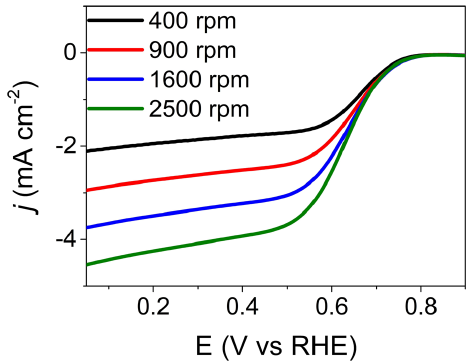
saturated 0.1 M KOH at 10 mV s -1 and Figure 7. ORR curves in O 2 different electrode rotation rates for N-graphene.